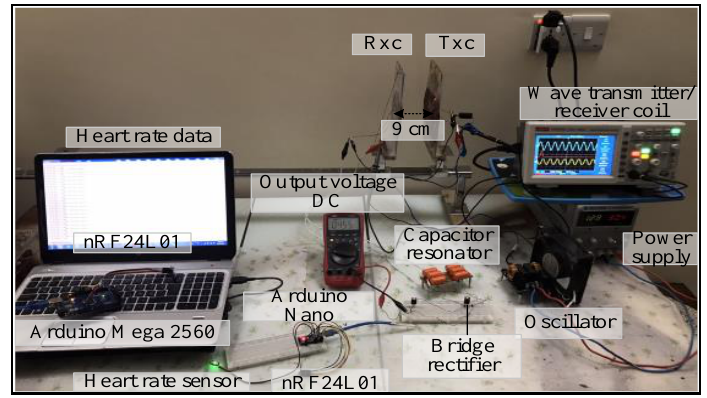
Figure 5. A snapshot of the MRC system at 9 cm for first topology for real time.